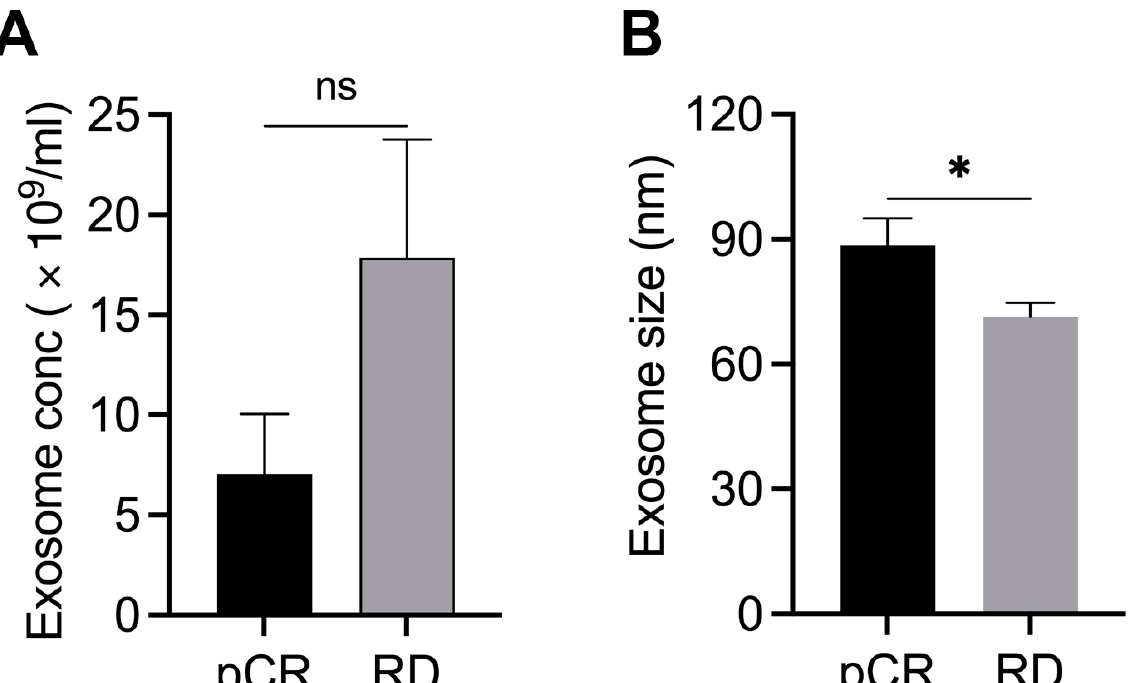
Figure 1. Characterization of exosomes in plasma samples from patients with BC showing pCR ( n = 8) or RD ( n = 8) after NAC. Bar graphs showing the concentration ( A ) and mean size ( B ) of exosomes in patients with pCR or RD after NAC. Bars indicate mean ± SEM. Unpaired two-tailed Student’s t -test with Welch’s correction was used to determine statistical significance (ns, non-significant; * p <